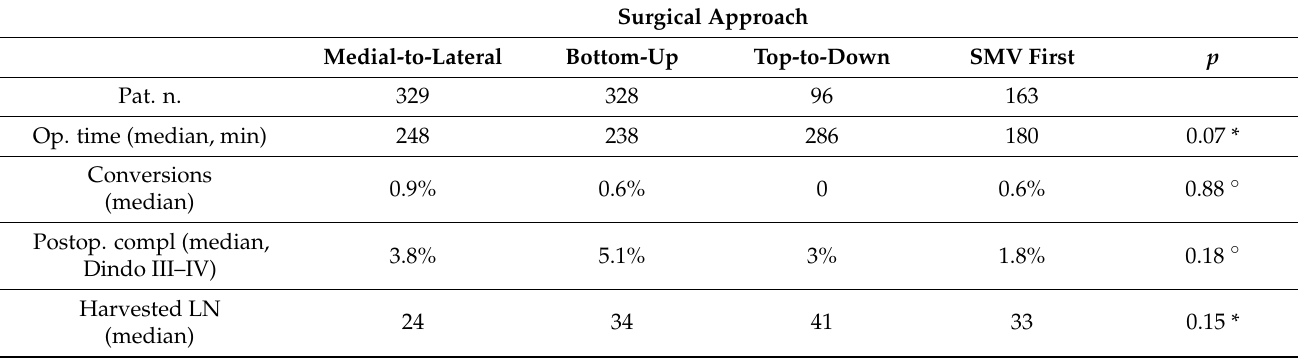
Table 3. Clinical and oncologic outcomes of robotic CME for right colectomy. Surgical